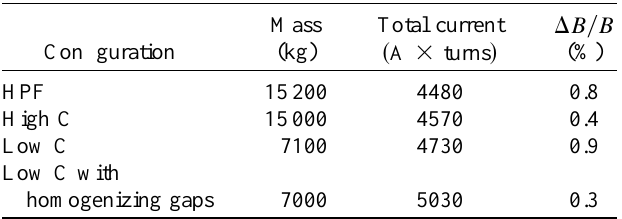
TABLE II. Characteristics of the four configurations.